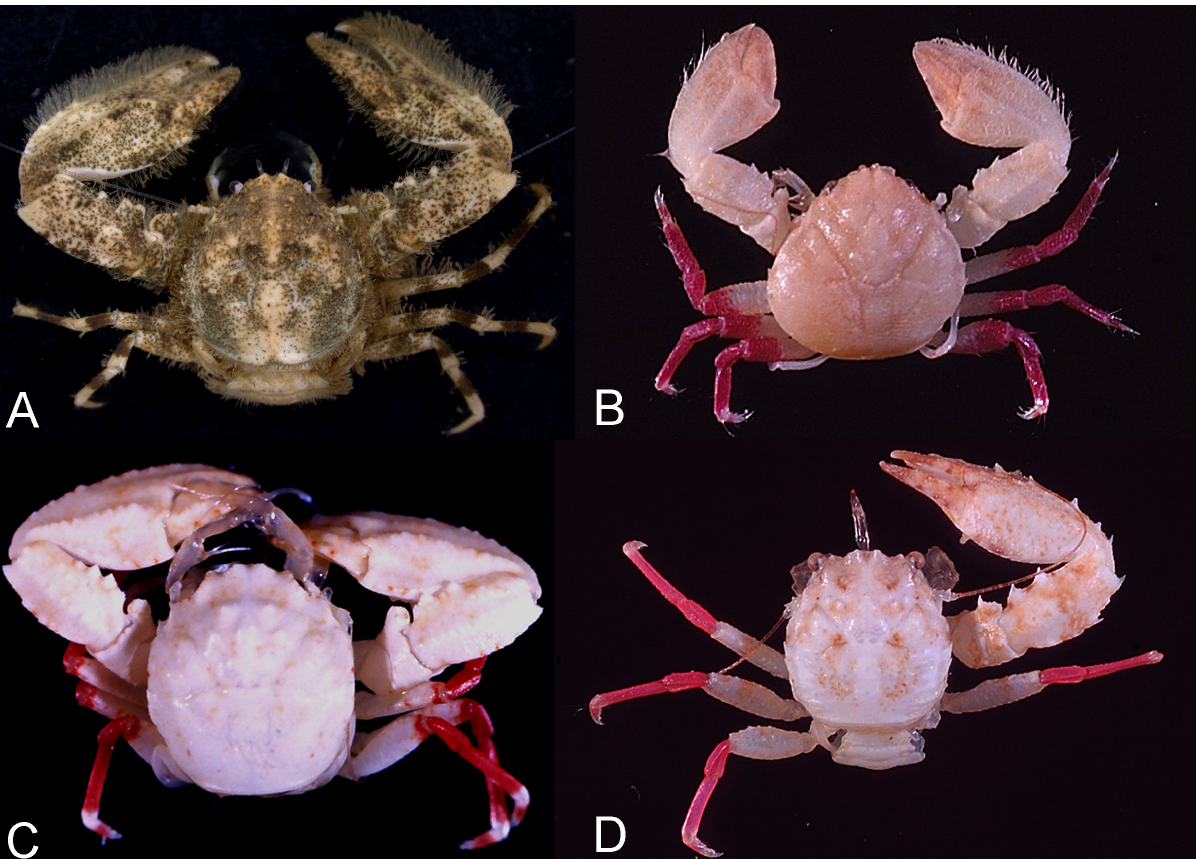
Figure 1. Entire animal, dorsal view. A, Enosteoides melissa (Miyake, 1942), male (cl 12.6 mm), RUMF-ZC 4310, Okinawa Island; B, Enosteoides palauensis (Nakasone and Miyake, 1968), female parasitized by rhizocephalan (cl 2.6 mm), ZRC 2016.0058, Panglao Island, stn S7; C, Enosteoides turkayi n. sp., holotype, female (cl 4.5 mm), NMCR, Balicasag Island; D, Enosteoides turkayi n. sp., missing specimen, Panglao Island, stn